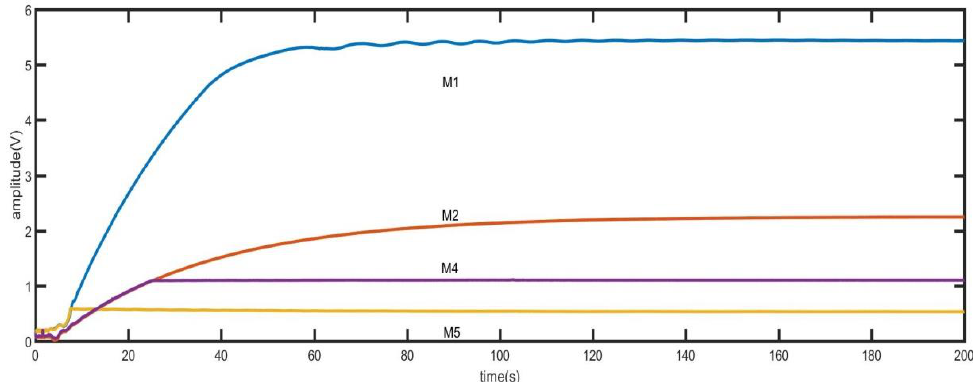
Figure 10. The time of quick step response.